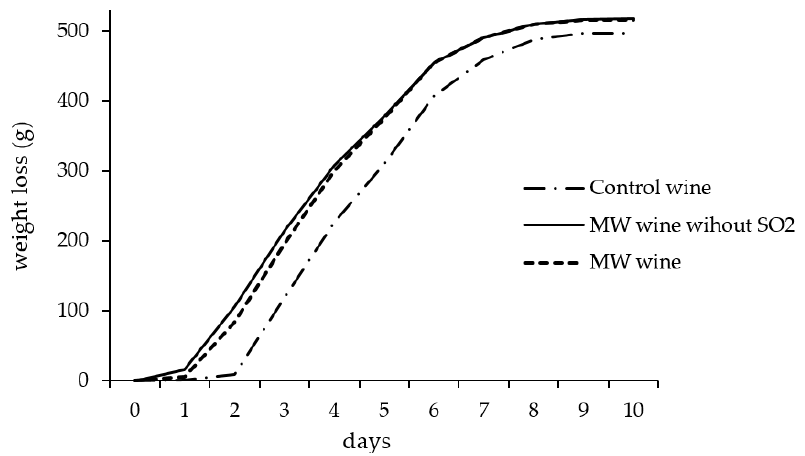
Figure 2. Alcoholic fermentation kinetics indicated by means weight loss in control wine and wines from microwave maceration elaborated with and without SO 2 . “Control wine”: no treatment applied; “MW wine”: microwave treatment at 700 W, 12 min of grape crushed; “MW wine without SO 2 ”: microwave treatment at 700 W, 12 min of grape crushed and elaborated without SO 2